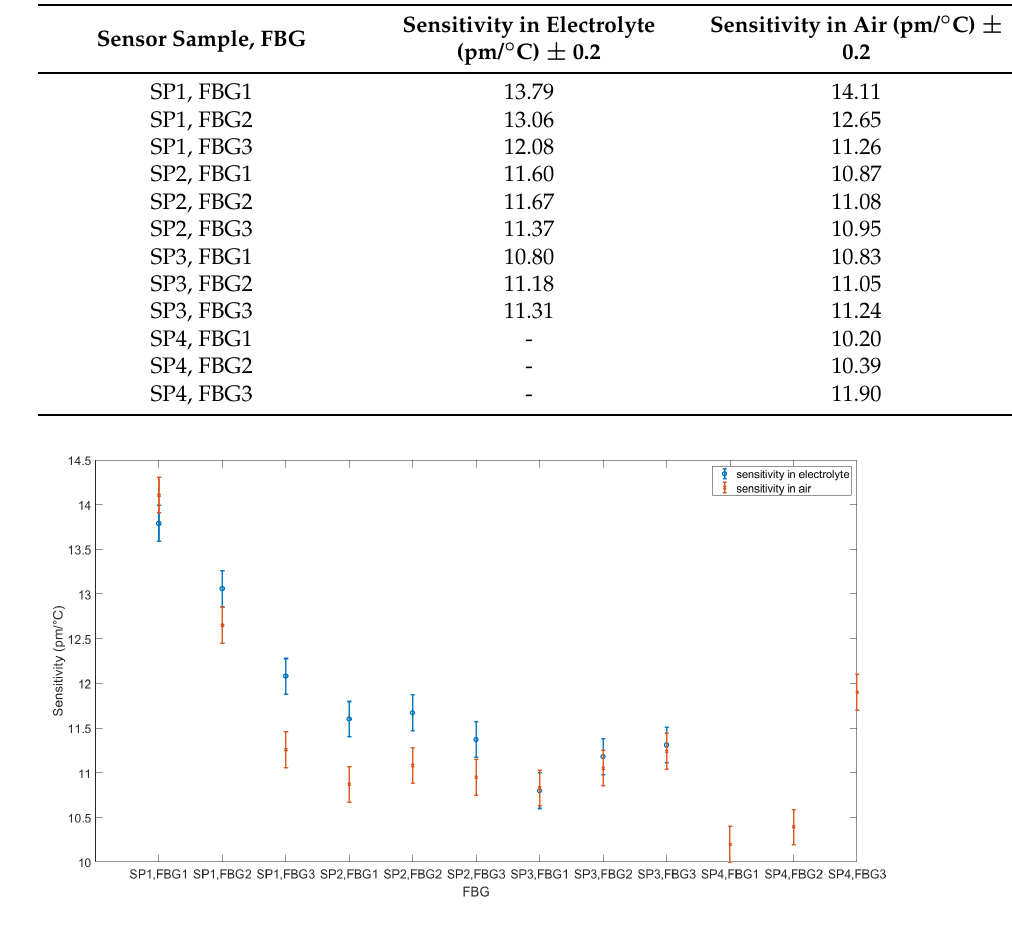
Figure 9. Sensitivity comparison between the calibration in air and the electrolyte. SP1: optical fiber in PEEK capillary, single-point mounting; SP2: optical fiber in fused silica tube with polyimide coating, single-point mounting; SP3: optical fiber in fused silica tube, removed polyimide coating, single-point mounting; SP4: optical fiber in fused silica tube, removed polyimide coating, double-point mounting. During calibration, SP1 shows hysteresis between heating and cooling in both the air and electrolyte cases. SP2 and SP3, on the other hand, show no hysteresis in either case. SP4 shows no hysteresis in air and cannot be evaluated in the electrolyte. Table A1 lists the Bragg wavelengths at 20 °C for the measurements in the electrolyte and air. For SP1,